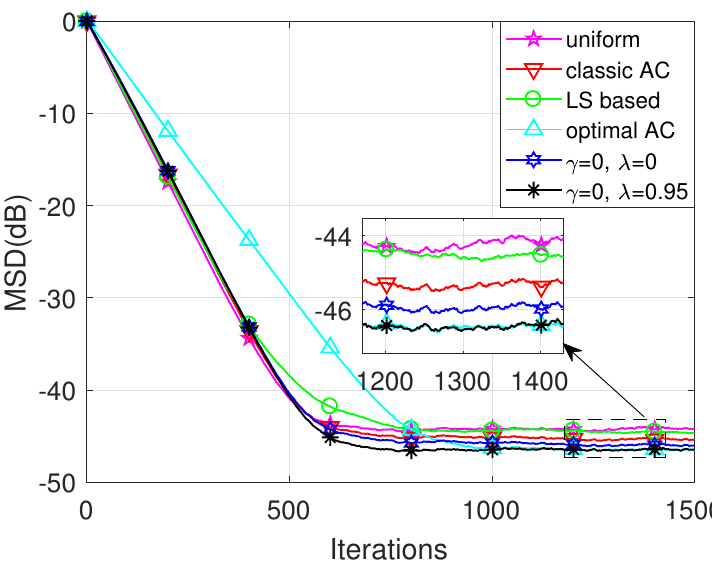
Figure 4. The MSD learning curves under tracking scenarios.